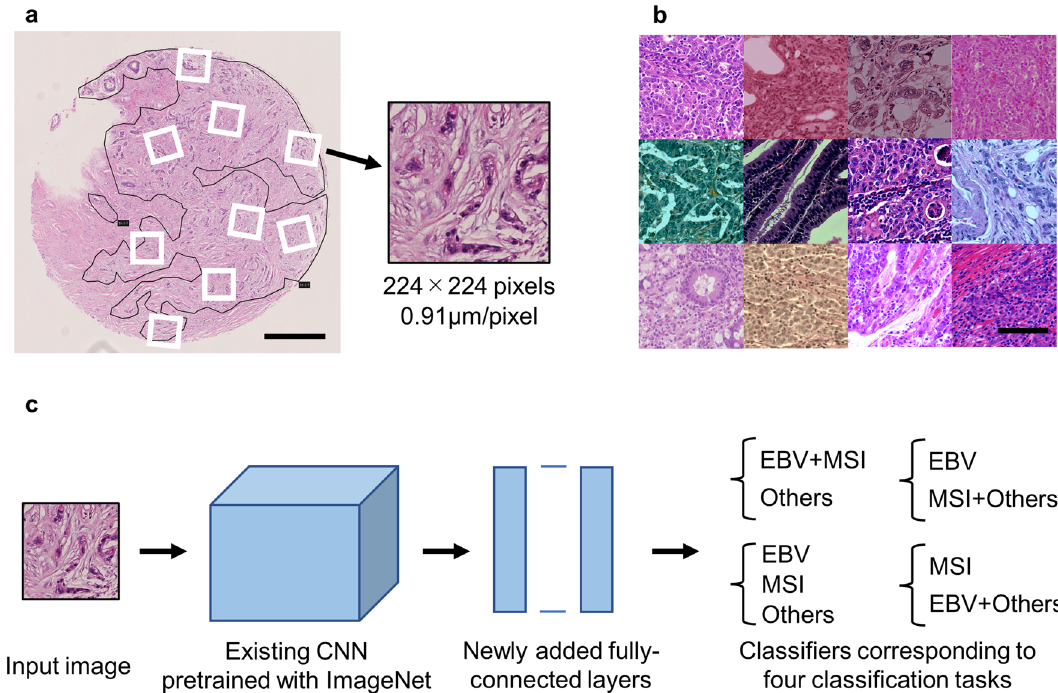
Figure 1. Image processing and the architecture of neural networks. ( a ) Representative image of tissue microarray prepared from cases of gastric cancer. Many small images (224 × 224 pixels) were sampled from annotated tumor areas at random positions and angles. Scale bar: 500 µm. ( b ) Sampled images after data augmentation (random change of color tone and blurring). Scale bar: 100 µm. ( c ) The architecture of neural networks: Fine-tuning of existing CNNs (VGG16, VGG19, ResNet50 and EfficientNetB0) was adopted. Classifiers corresponding to four classification tasks were added on the top. CNN—convolutional neural